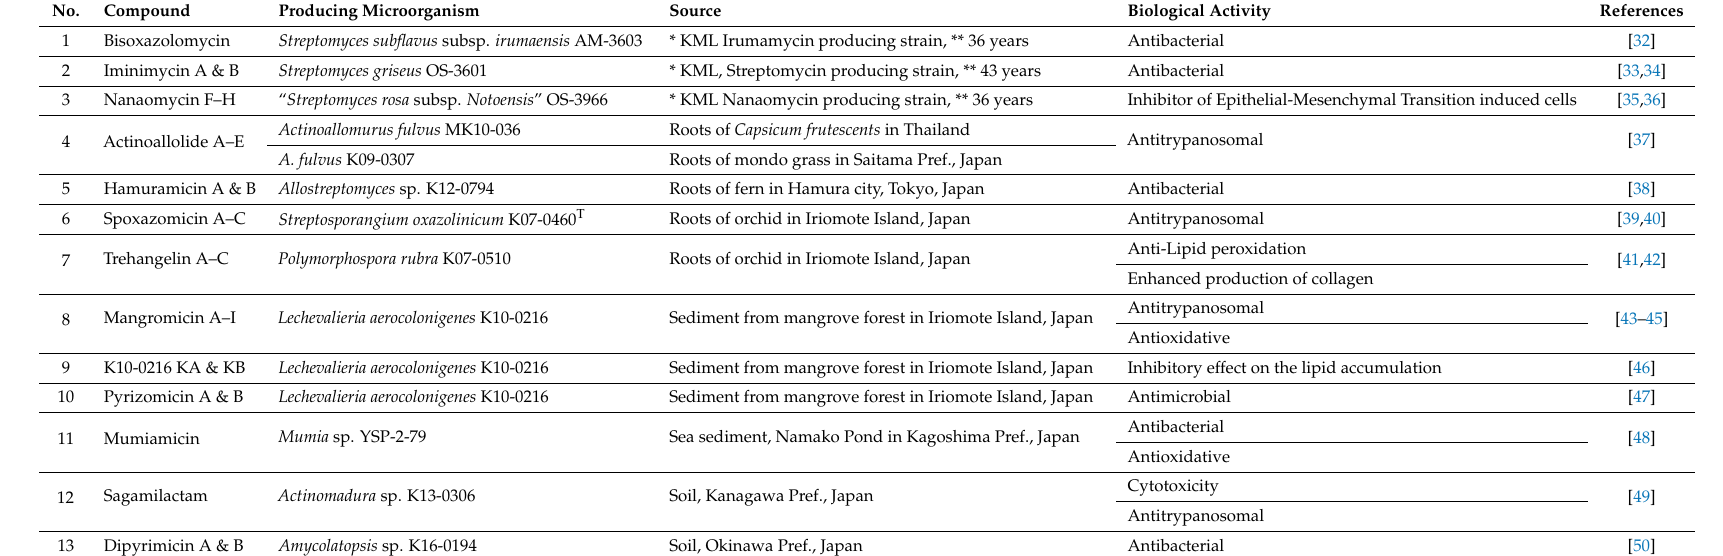
Table 1. Compounds discovered by physicochemical screening of actinomycete strains (March